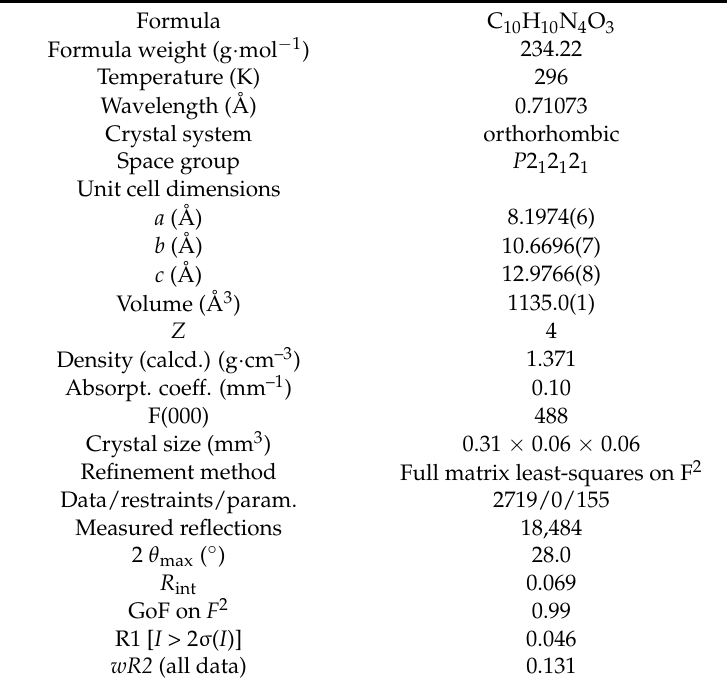
Table 1. Crystal data and structure refinement parameters of Compound 2 .